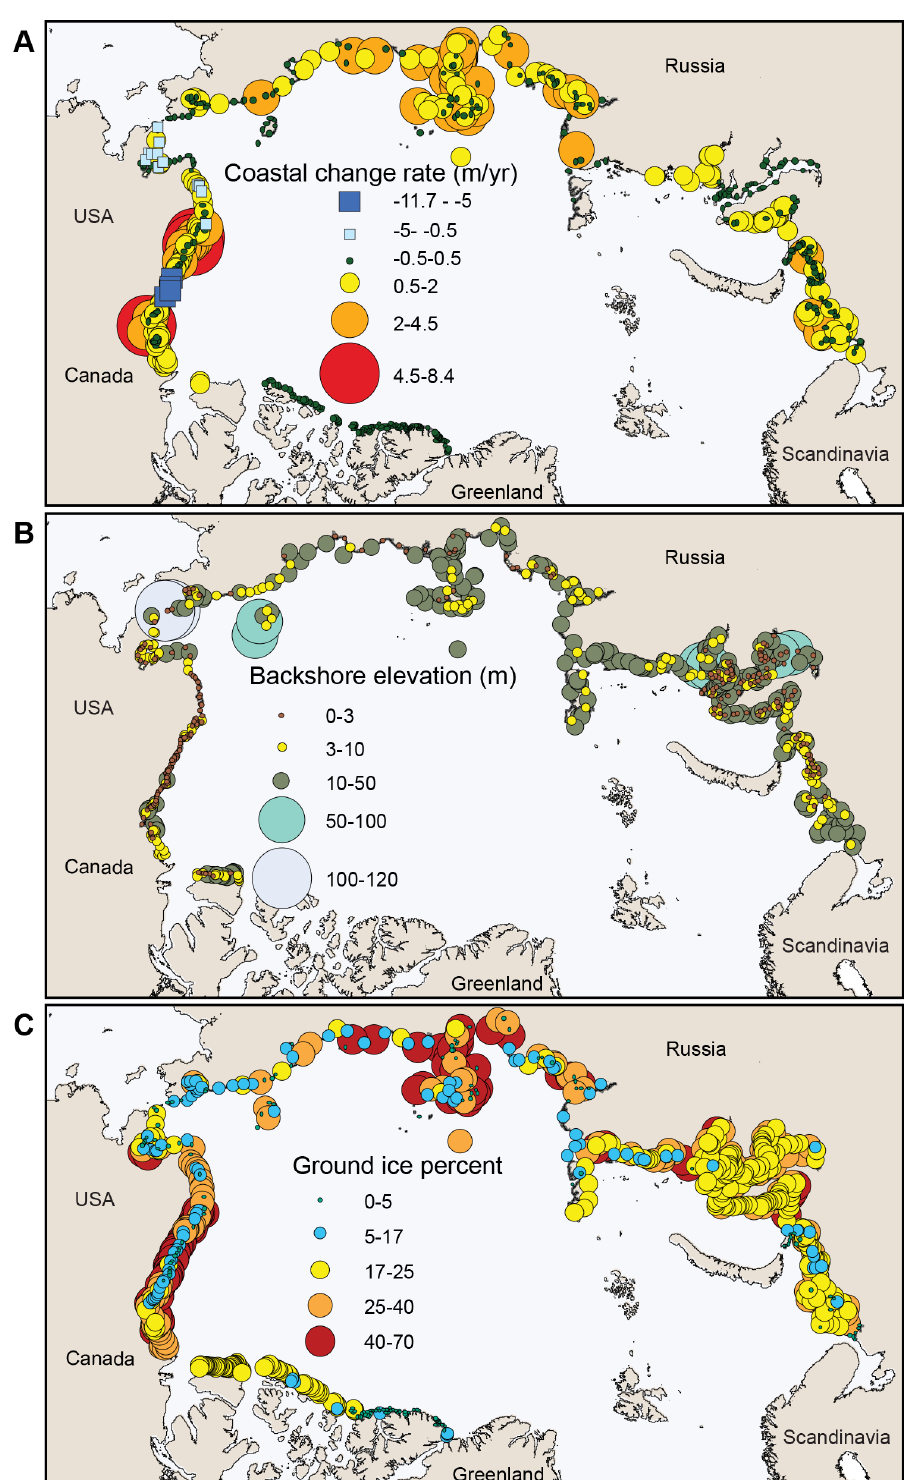
Figure 5. Whole-Arctic coastal erosion and deposition (a) , backshore elevation (b) , and ground-ice content (c) from the Arctic Coastal Dynamics database (Lantuit et al., 2012). A total of 49% of the segments have erosion rates below 1myr − 1 and 40% of the segments have rates below 2myr − 1 . Deposition along the Beaufort Sea occurs in deltaic regions from the Colville River east and along coastal barriers, spits, and forelands west of the Mackenzie River delta. The backshore elevation provides control on the vulnerability of a coast to inundation. Areas with high ice content can experience rapid erosion and are susceptible to changes in the nearshore water